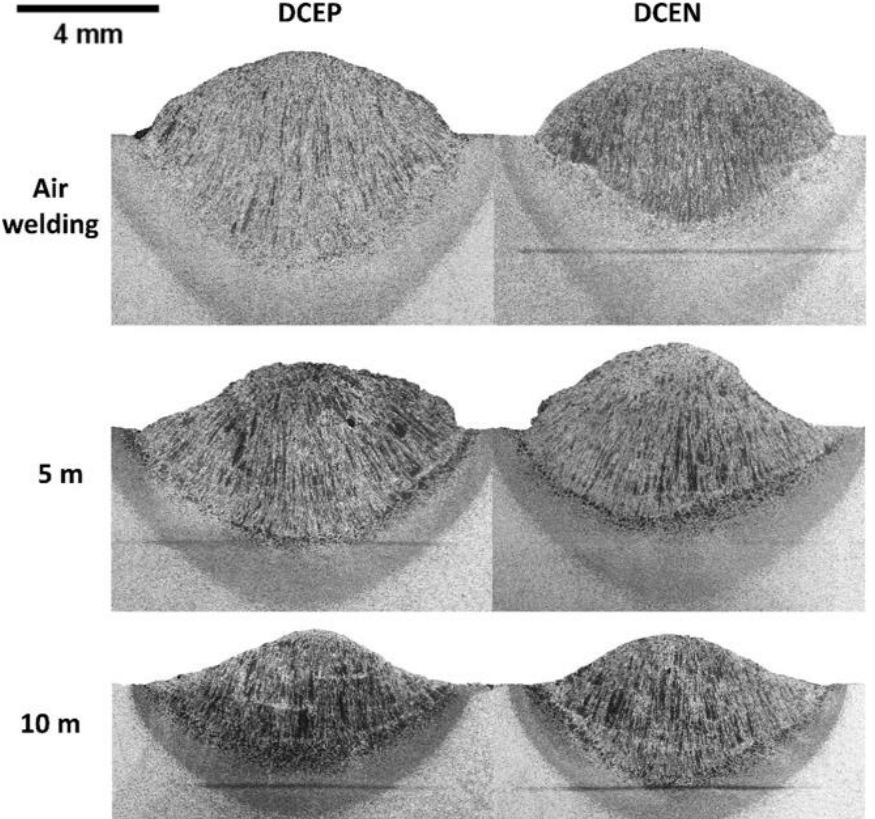
Figure 10. Macrographs of welds made with the rutile electrode. The black line is central segregation representing higher carbon content, which was diffused through an increase in temperature in the HAZ.